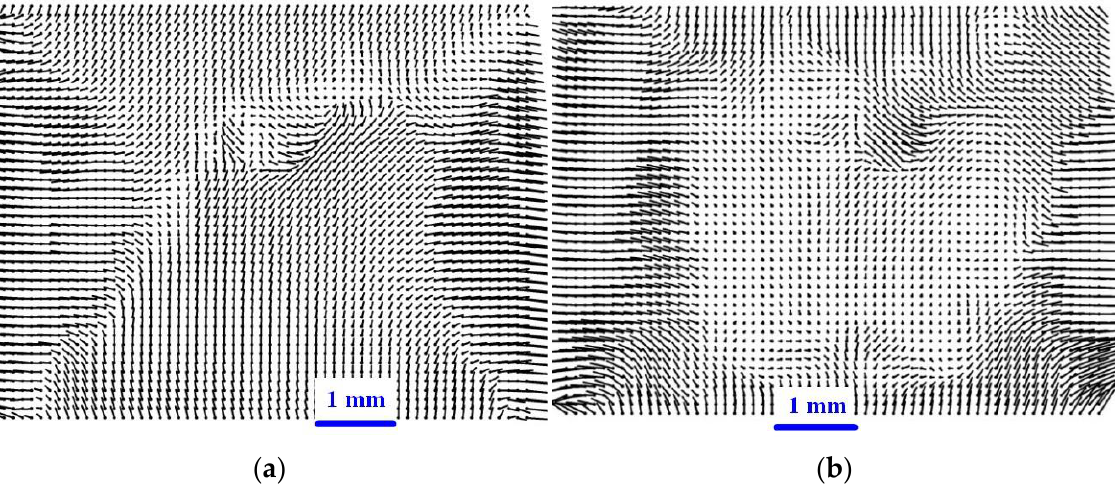
Figure 23. Fields of deformation vectors of segmented porous alumina: Sample #1, ε = 0.077, ∆ ε = 0.010 ( a ); Sample #4, ε = 0.060, ∆ ε = 0.0063 ( b ). Here, Ns is the length of the square-shaped contour. To simplify the calculations, the vectors falling on the corners of the squares will not be taken into account, and, therefore, given that ∆ y i = ∆ x j = T , Formula (6) can be rewritten